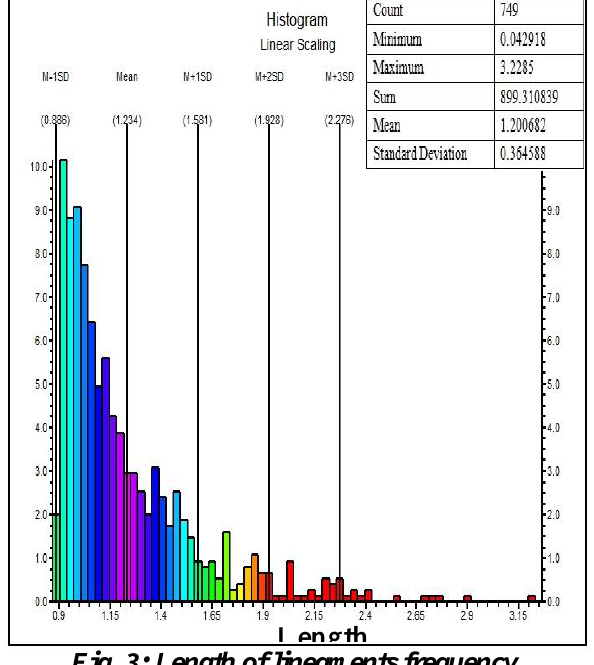
Km Fig. 3: Length of lineaments frequency.